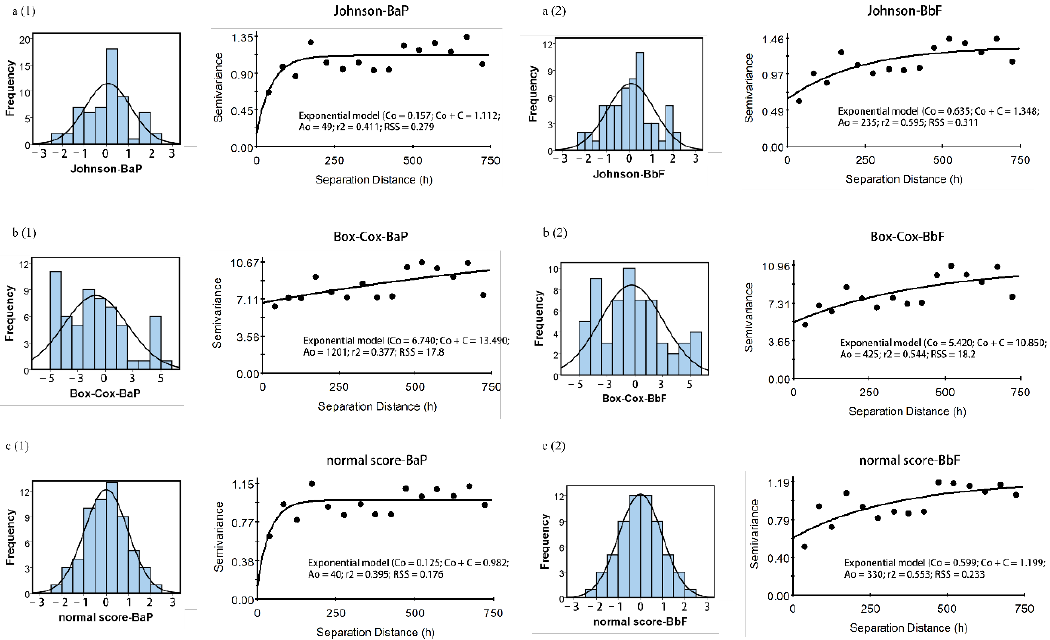
Figure 3. Left : Histograms of the transformed soil BaP ( a1 , b1 , c1 ) and BbF ( a2 , b2 , c2 ) concentrations: (a) Johnson transformed data; (b) Box-Cox transformed data; (c) normal score transformed data. Right : Experimental semivariograms and fitted parameters corresponding to the transformed data. Table 3. Modelled semivariogram parameters of soil PAHs concentrations.